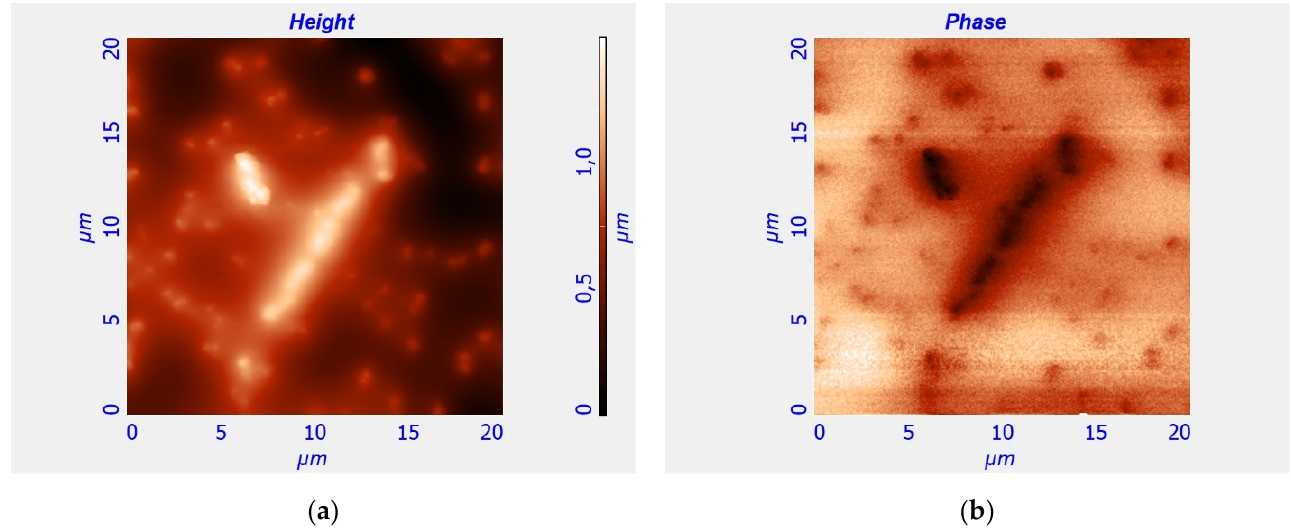
Figure 6. AFM ( a ) and MFM ( b ) images of EcN cells cultivated on medium supplemented with iron chelate. The left image represents the AFM of EcN cells, i.e., the topography of the surface of EcN cells at the cover glass. The color bar for the left image shows the height in micrometers illustrating the shape and size of EcN cells. The right image represents the MFM (of the same EcN cells as in left image) in the dynamic MFM mode. The abrupt change in the colors between the inside and outside regions of EcN cells in the right image means that the force of magnetic interaction of the magnetic tip of the cantilever with the EcN cells differs in a step-like manner from that the force of interaction with the diamagnetic cover glass.